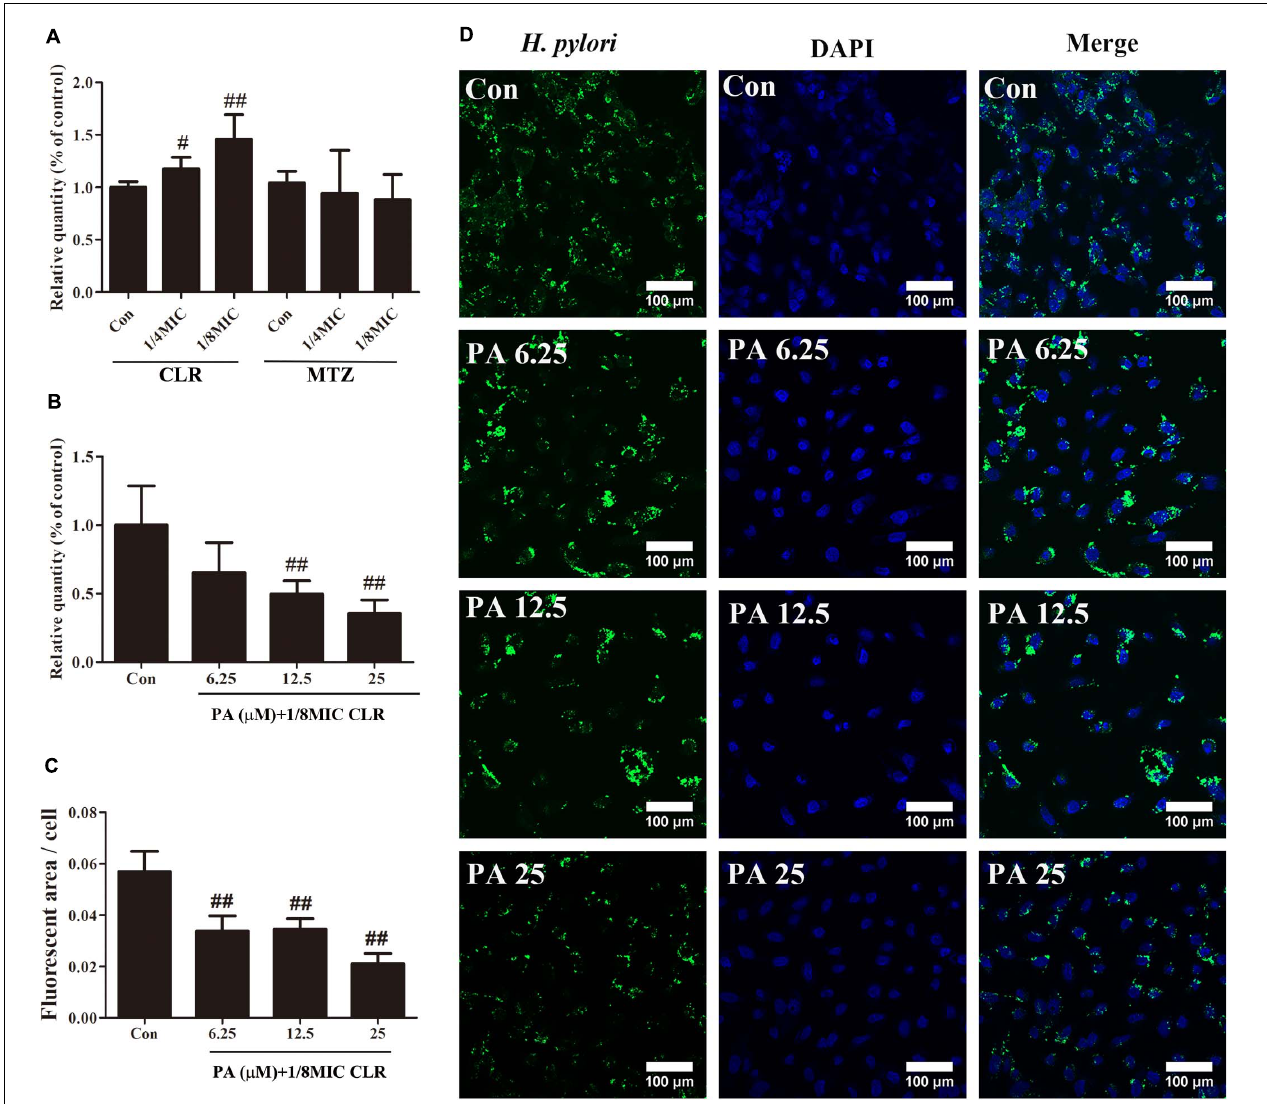
FIGURE 3 | Number of intracellular H. pylori stimulated by antibiotics and PA. (A) Influence of low-dose CLR and MTZ on the number of intracellular H. pylori . (B) Antagonism effect of PA on the increased invasion induced by CLR; a gentamycin protection assay was conducted to measure the CFU of intracellular H. pylori . (C) Quantitative results of the fluorescent area of H. pylori (green area) with treatment of PA and CLR. (D) Representative confocal images of intracellular H. pylori after treatment with PA and CLR. The above results are expressed as the mean ± SD ( n = 6). # P < 0.05, and ## P < 0.01 (compared with the results for the control